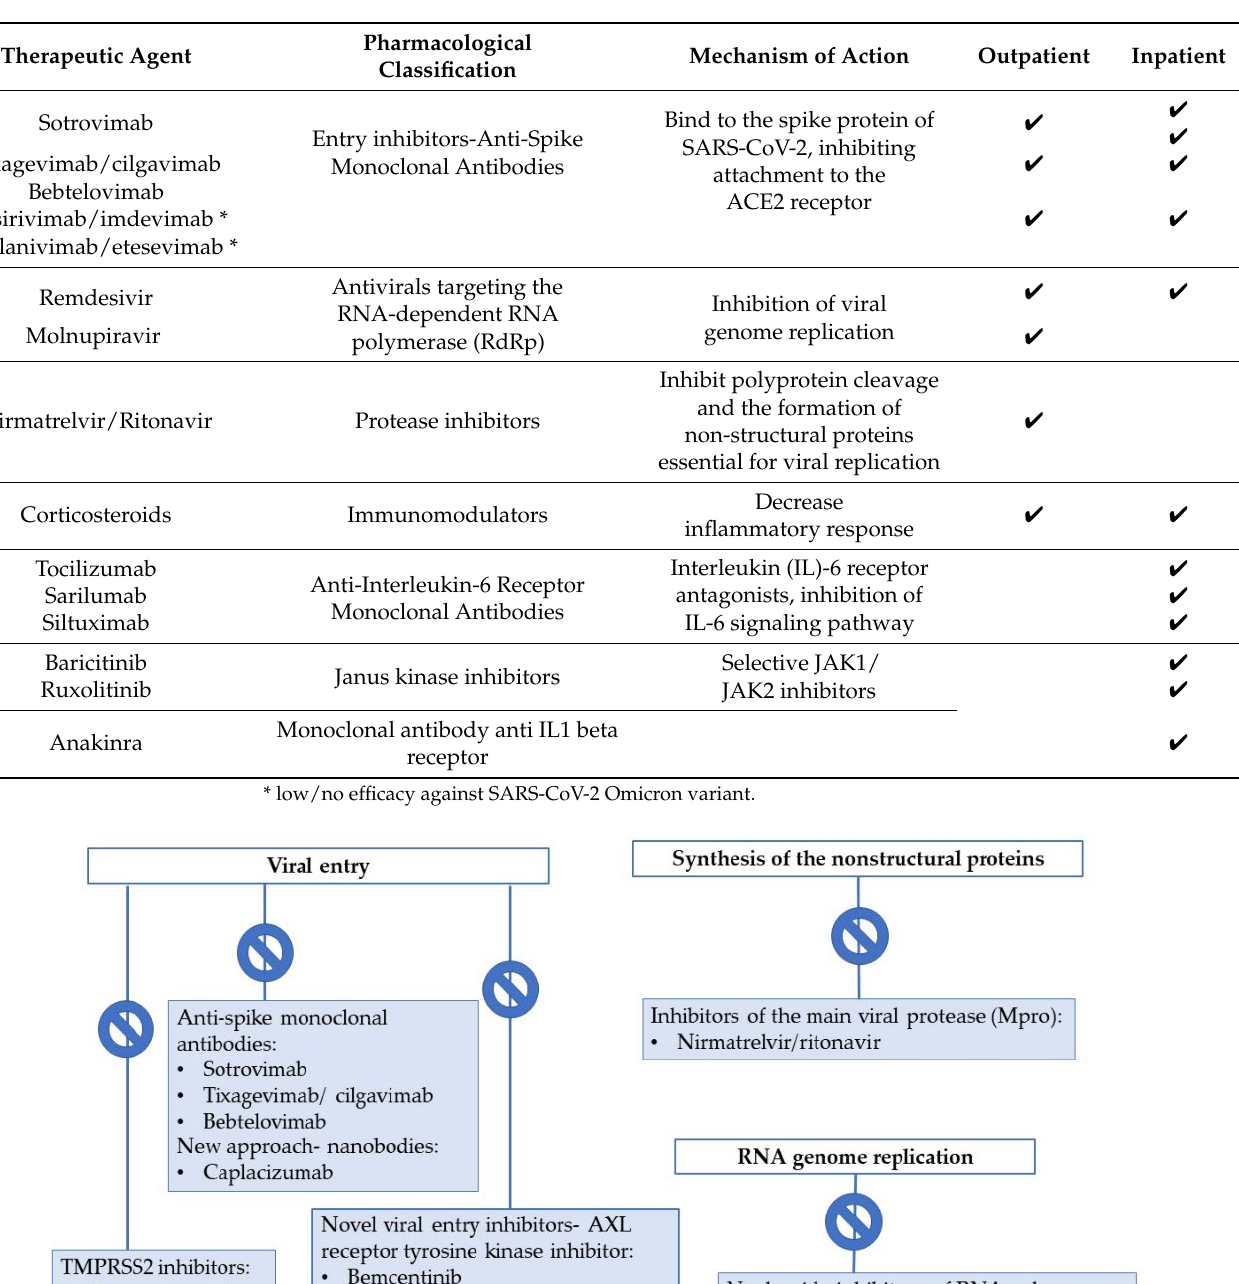
Table 1. Drugs currently used for COVID-19 therapy.